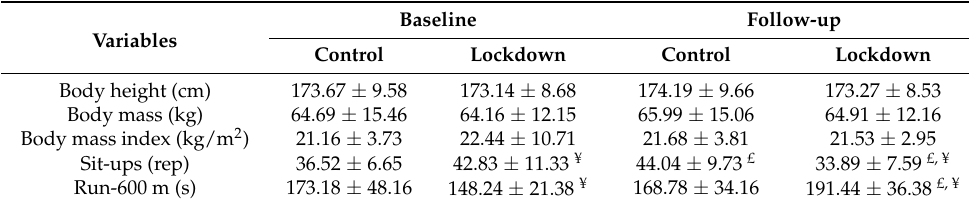
Table 2. Descriptive statistics (presented as means ± std. dev.) and post-hoc differences for study variables in the control and lockdown groups at baseline and follow-up.